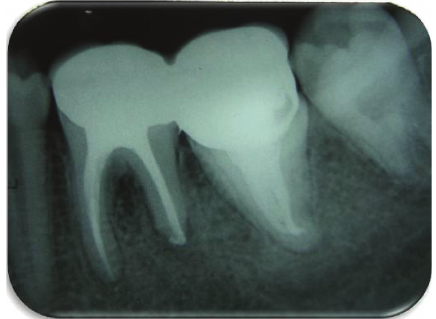
Figure 4: Recall radiograph 1-year